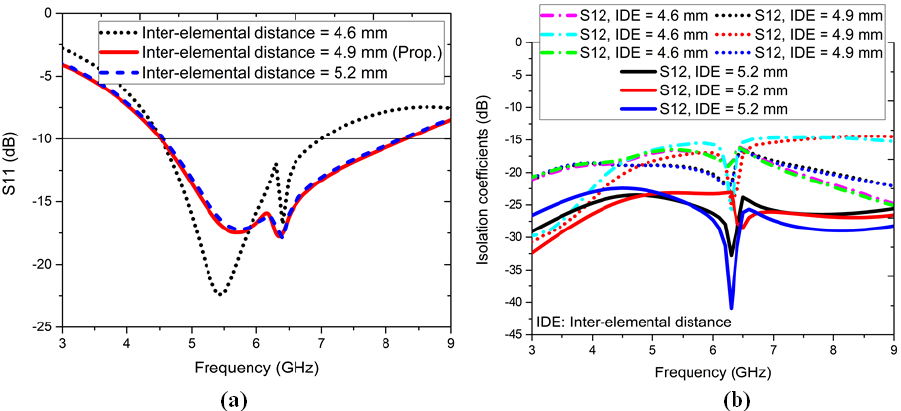
Figure 12. Variation of interelemental distance (IDE): ( a ) S11, dB parameter and ( b ) S12, S13, and S14 dB